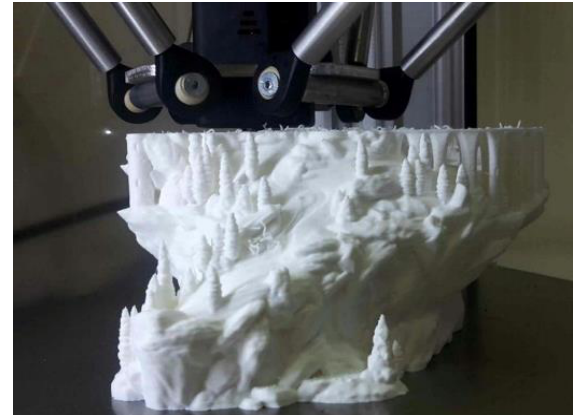
Figure 12. Three prototypes of the Medusa mask, vertical position. Different settings of fill density (10-15-20 %).